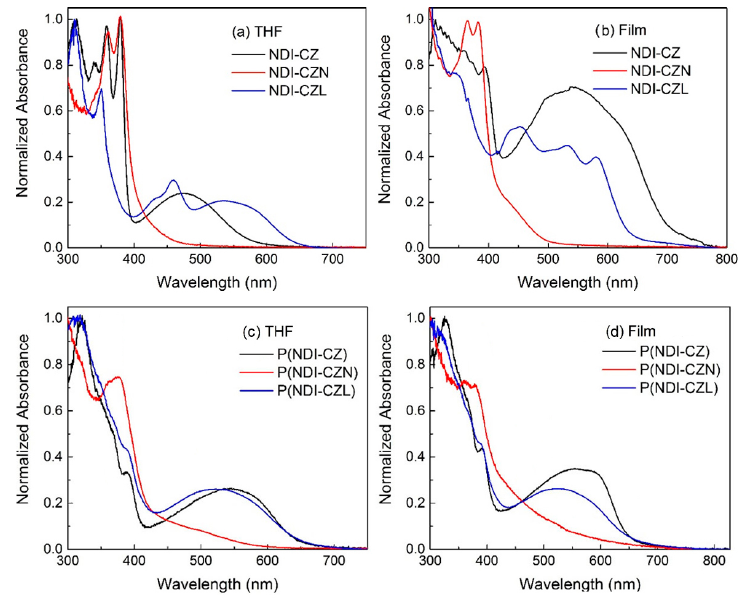
Figure 5. ( a , c ) Solution UV-vis absorption spectra; ( b , d ) thin-film UV-vis absorption spectra.